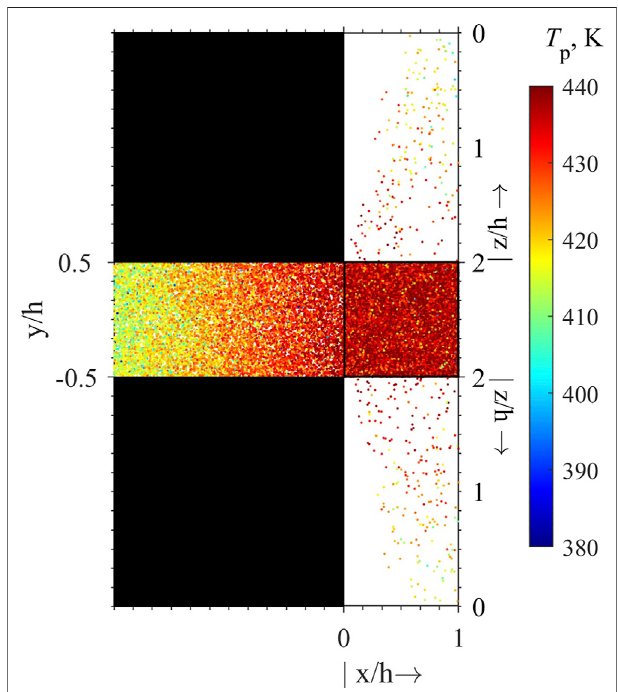
FIGURE 12 | Location and temperature of the fi rebrands deposited on the facesofthestructure withlengthand width of3 mand heightof6 m. Dots indicate the positions of the deposited fi rebrands on the block faces. The leeward face is not shown since no fi rebrands are deposited on it. The rectangles with the smallest number of dots are the lateral faces. The square between these two faces is the top face. The rectangle on the left of the top face is the windward